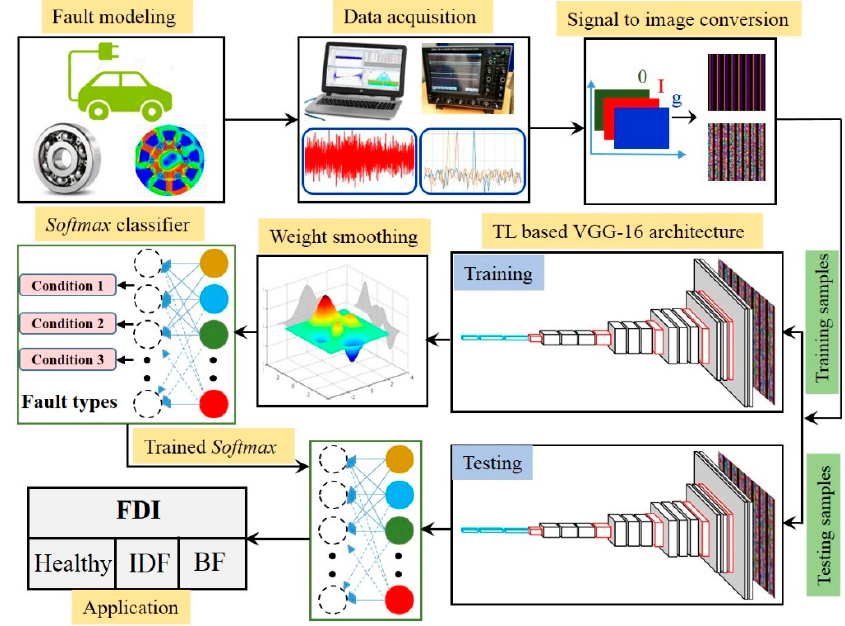
Figure 11. The methodology of the proposed fault detection and identification (FDI) method.